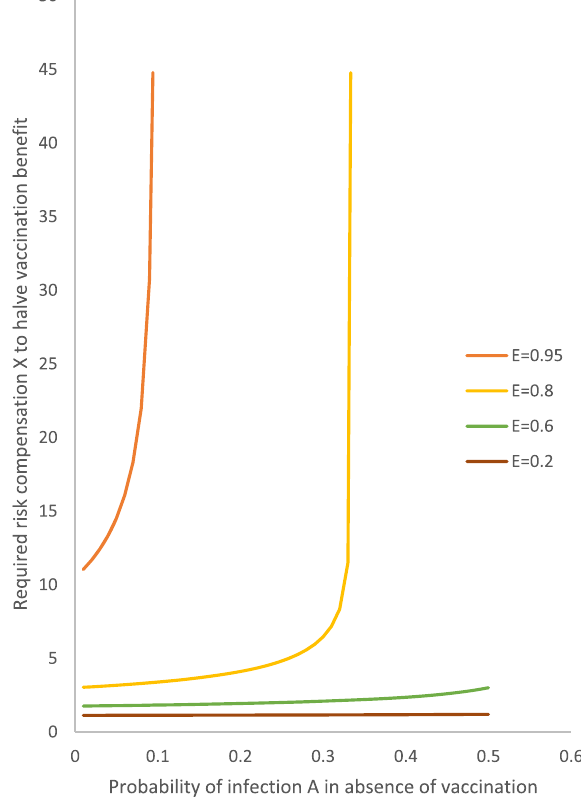
Fig. 2 Required risk compensation to halve the vaccination bene fi t. Scenarios presented with vaccine ef fi cacy (E) of 0.2, 0.6, 0.8, and